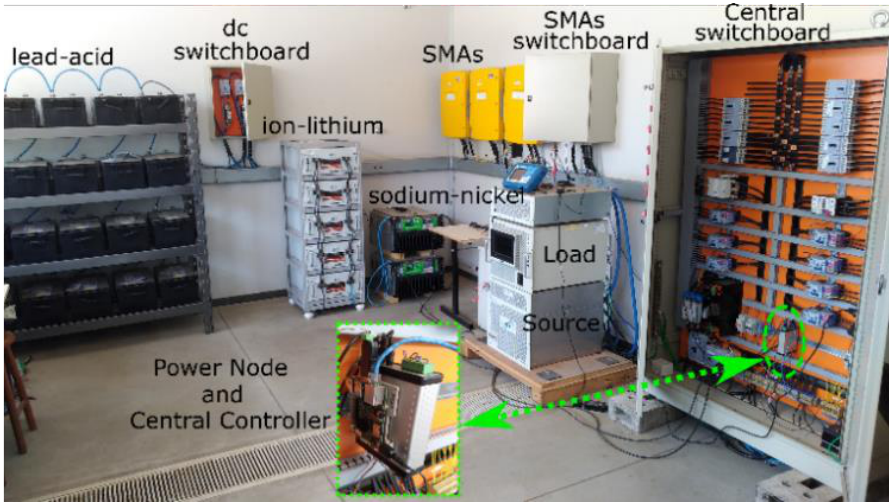
Figure 2. Actual installation of the single-controllable microgrid at UFMG, Brazil.